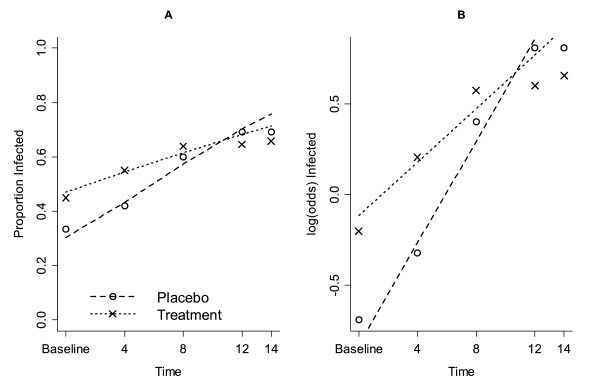
(A) The proportion of individuals with Plasmodium spp. parasites and (B) the log odds of individuals being infected with Plasmodium spp. parasites over time.